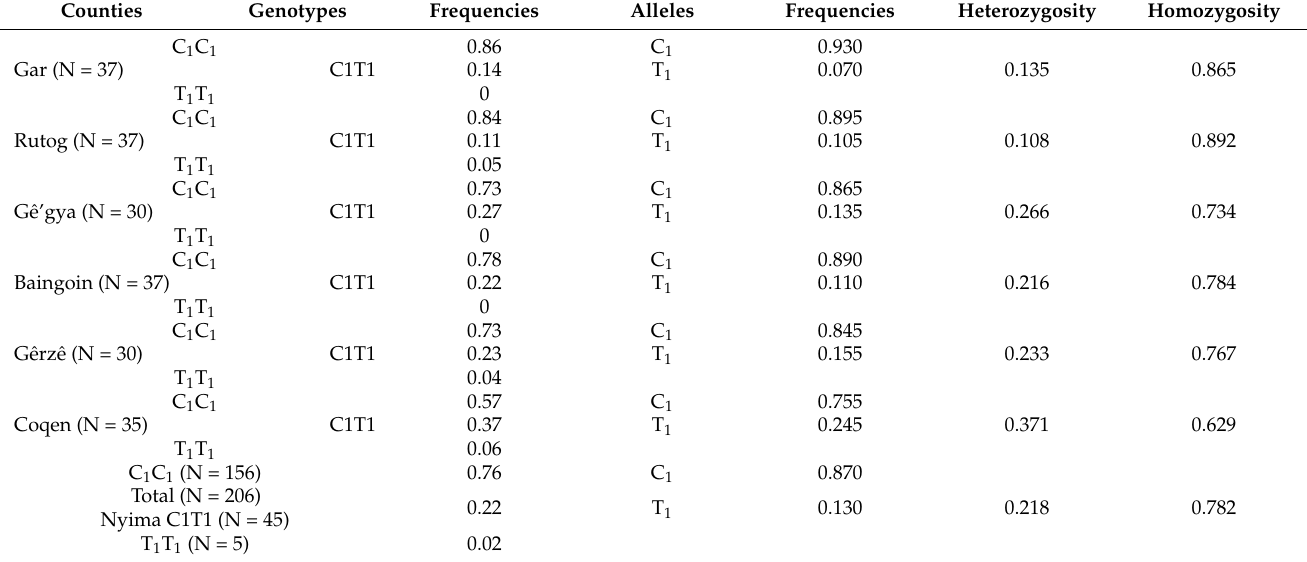
Figure 5. Relative mRNA expression of genes IGF-1 ( A ), FGF5 ( B ), and KAP 1.4 ( C ) in ear skin tissue of the Northwestern Tibetan cashmere goat among seven counties. Data are mean ± SD from three independent experiments. Different letters stand for significant difference ( p < 0.05).